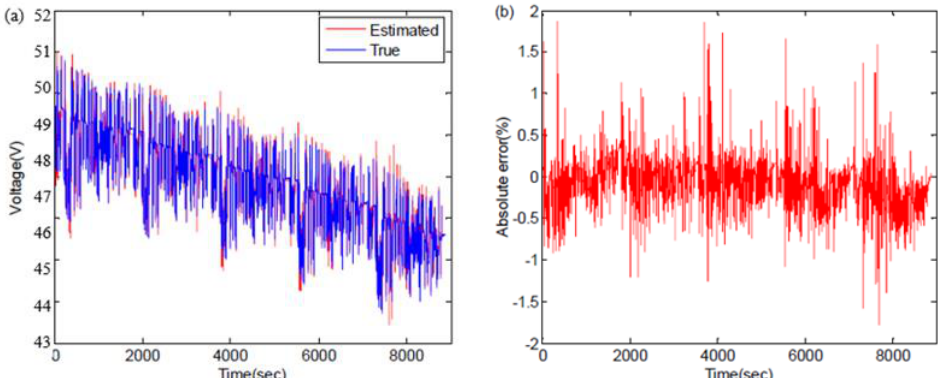
Figure 9. The terminal voltage estimation under UDDS cycles: ( a ) terminal voltage estimation; ( b ) terminal voltage estimation error.